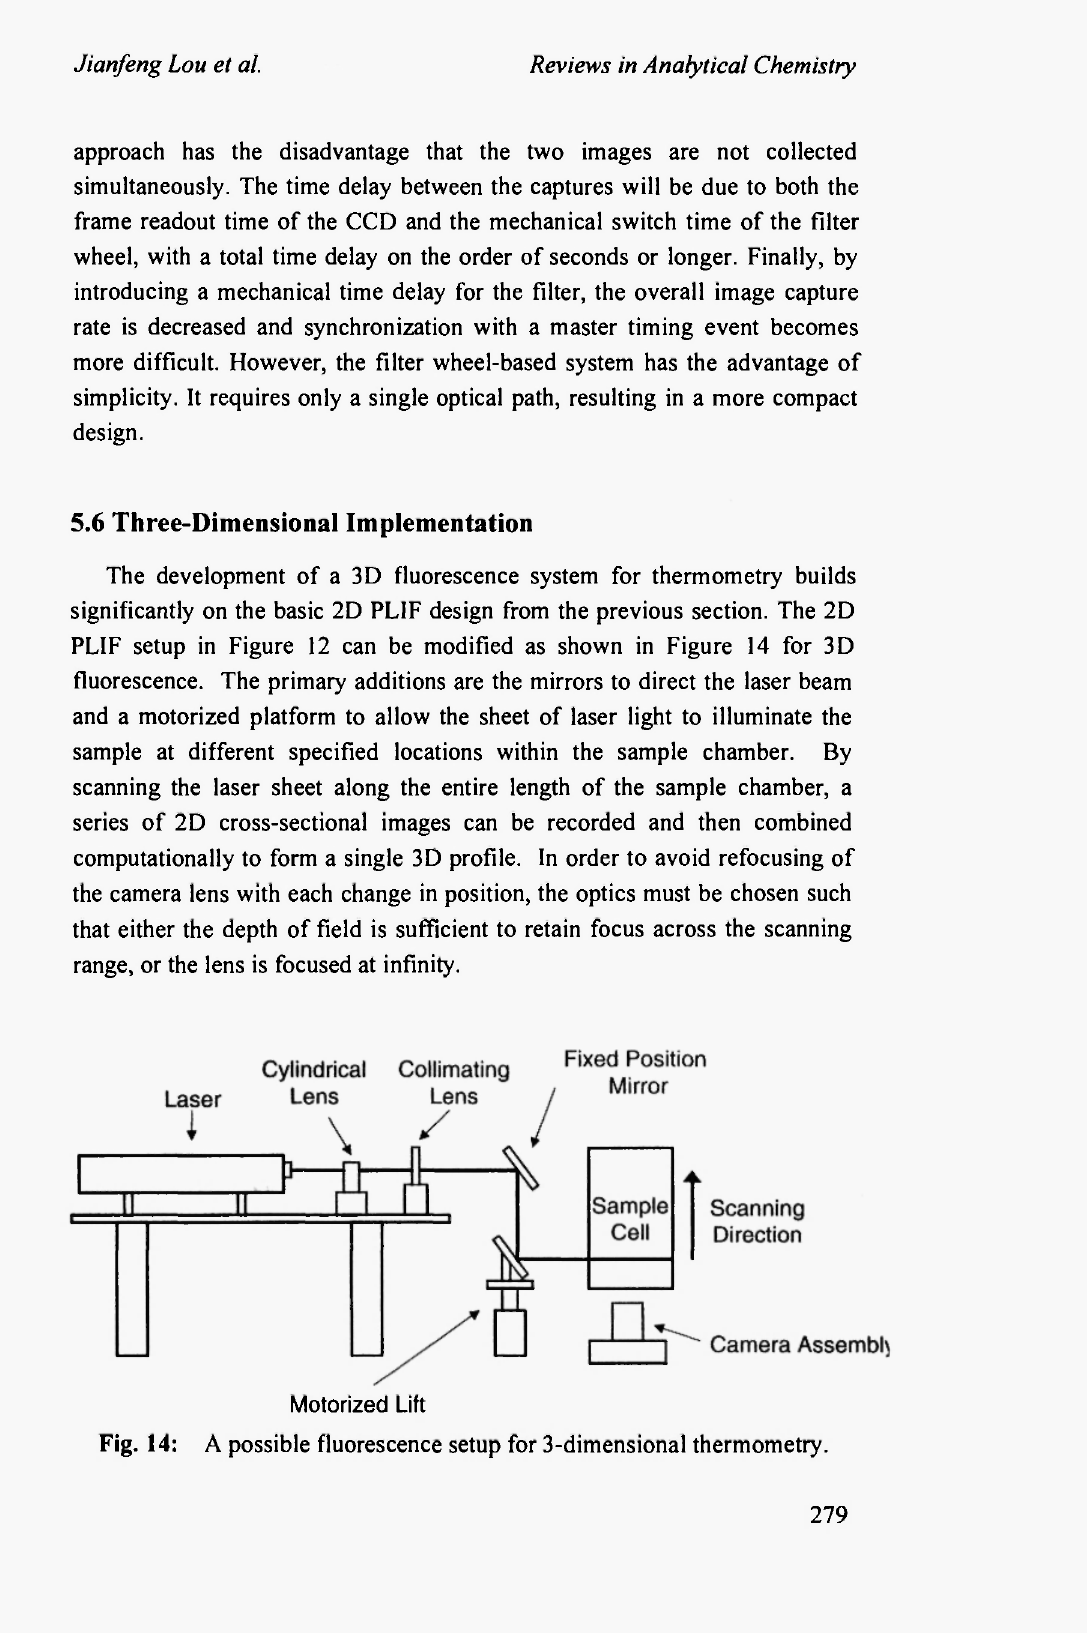
Fig. 14: A possible fluorescence setup for 3-dimensional thermometry.